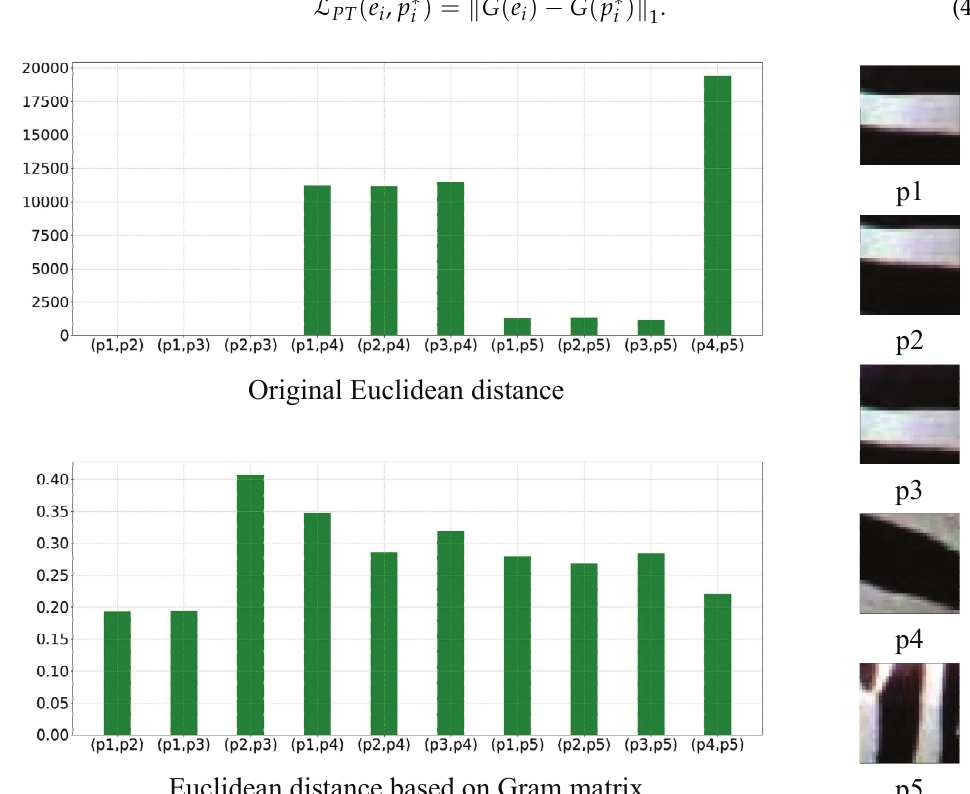
Figure 2. Comparison of the two distance calculation approaches with different texture information. (p1, p2) represents the distance between patch p1 and p2, and so